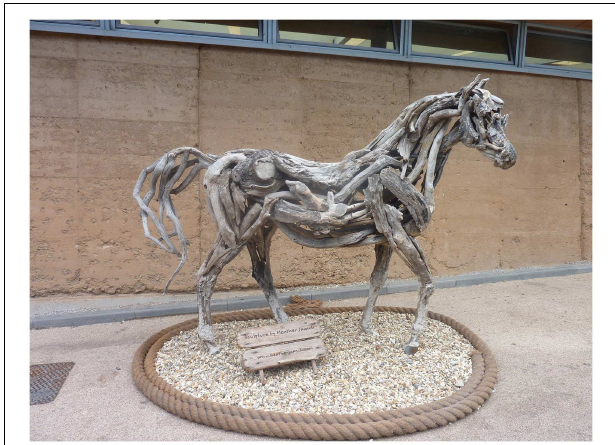
FIGURE 12 | Photograph of a sculpture of a horse made from driftwood by Heather Jansch. Photograph by the author,